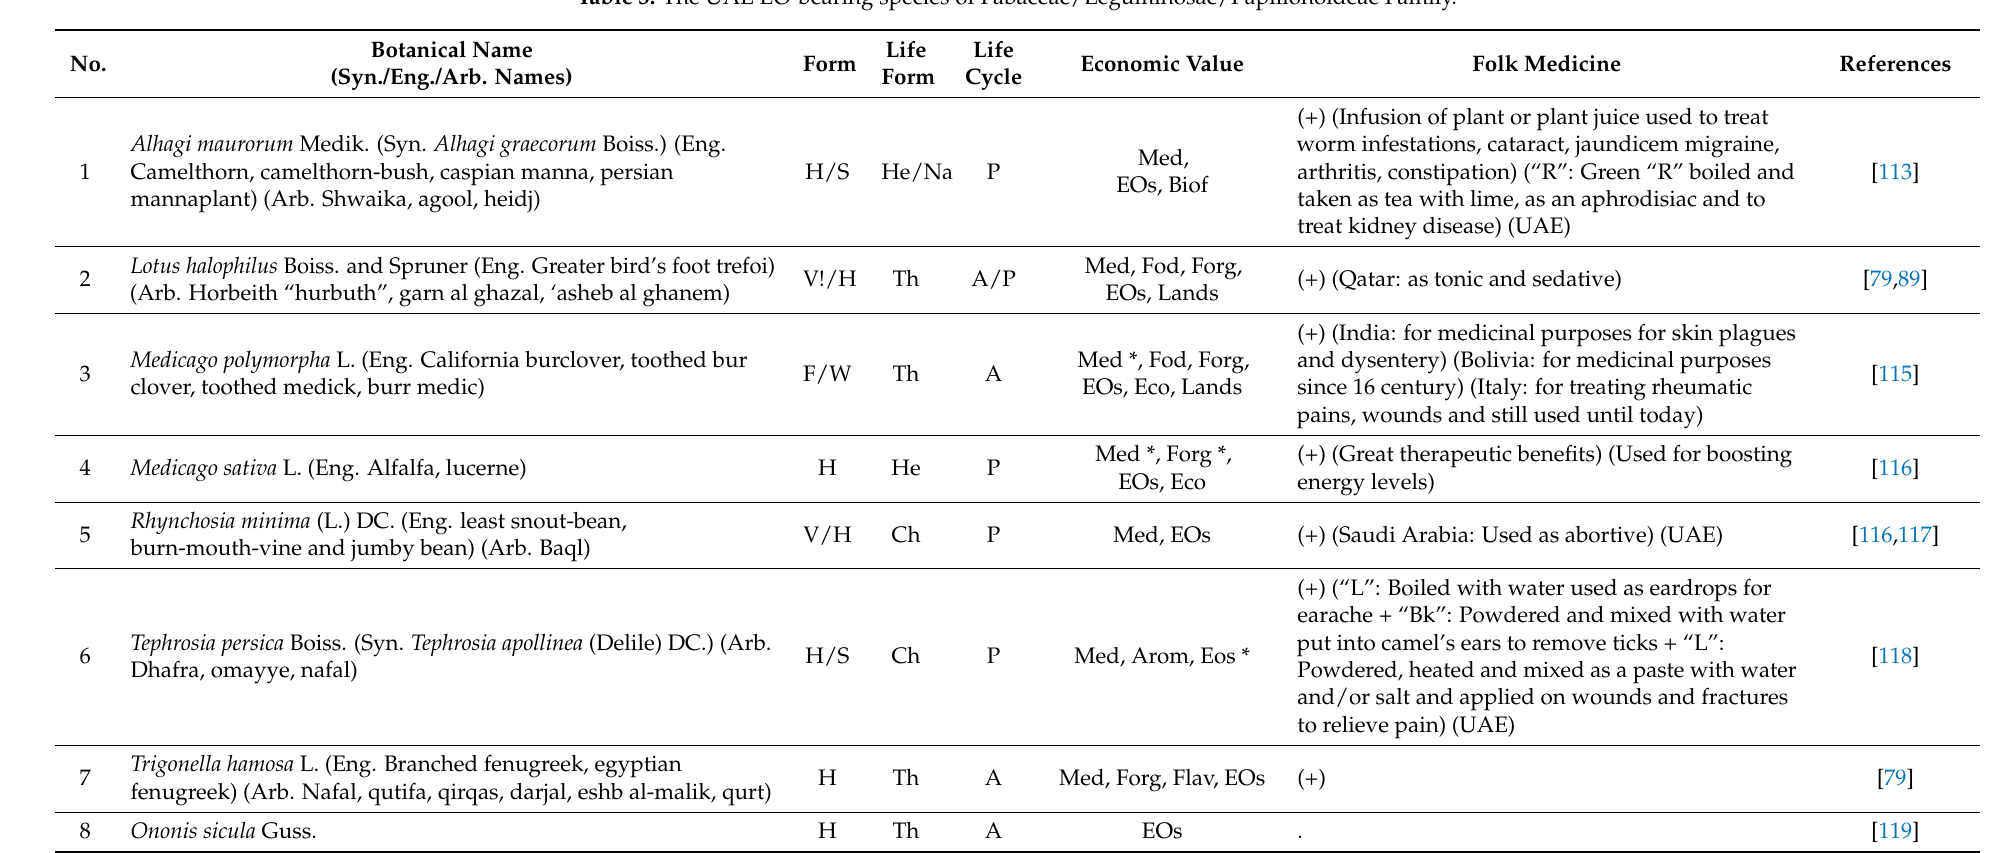
Table 3. The UAE EO-bearing species of Fabaceae/Leguminosae/Papilionoideae